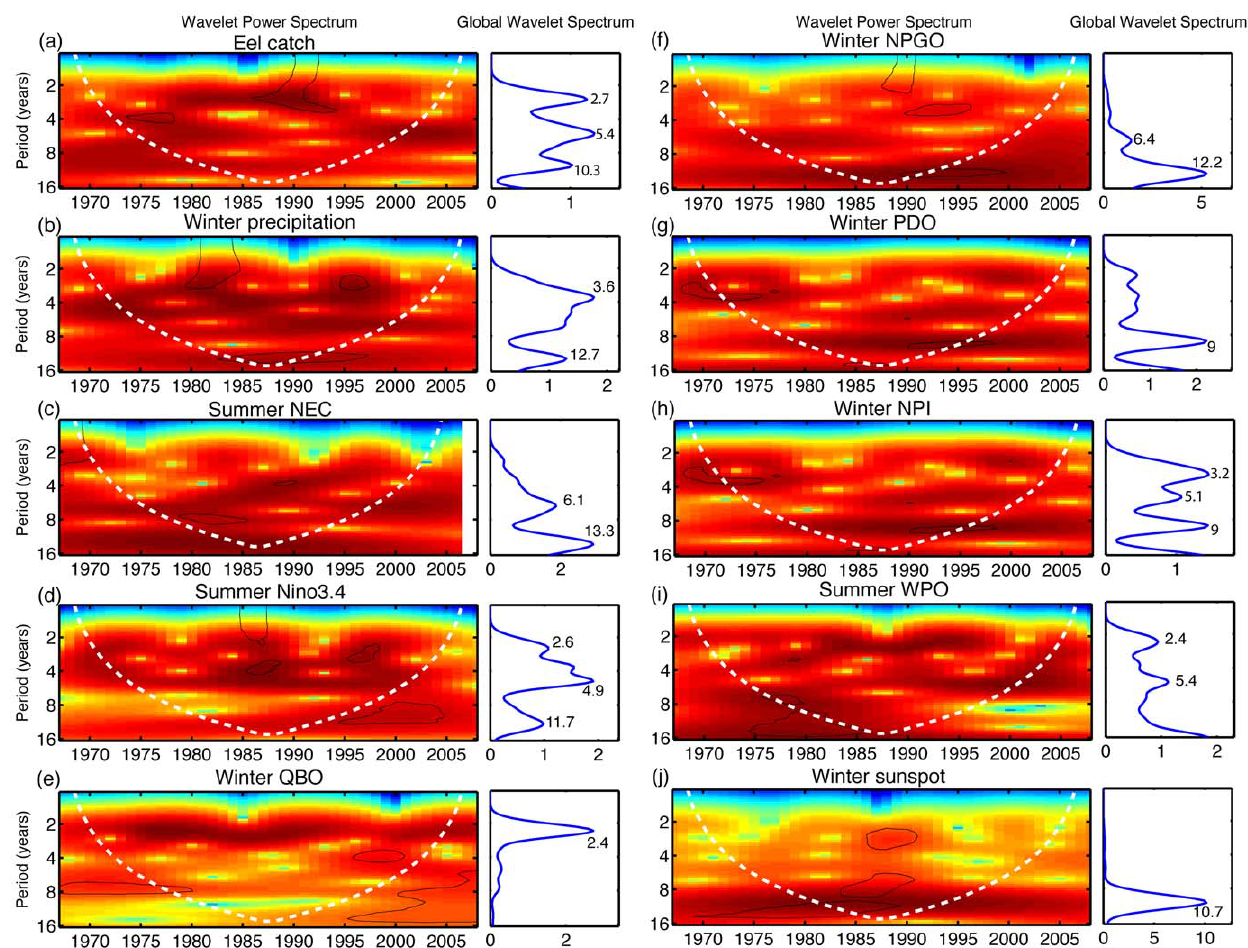
Figure 3. Results of wavelet analyses revealing the nonstationary fluctuations through time of the eel catch data as well as climate indices. The left panel represents the wavelet power spectrum and the right panel indicates the global power spectrum averaged over the time series for (a) log 10 (eel catch), (b) winter precipitation at the eel spawning area, (c) summer NEC bifurcation, (d) summer Nin˜o3.4 index, (e) winter QBO index, (f) winter NPGO index, (g) winter PDO index, (h) winter NPI index, (i) summer WPO index, and (j) winter sunspot numbers. The vertical axis represents period (years). The local wavelet power spectrum provides a measure of the variance distribution of the time series according to time and for each periodicity; high variability is represented by red, whereas blue indicates a weak variability. The solid black contour encloses regions of greater than 95% confidence for a red-noise process with a lag-1 coefficient, and the white dashed line area indicates the cone of influence where edge effects become important. For the global power spectrum, periods corresponding to the peaks are indicated.